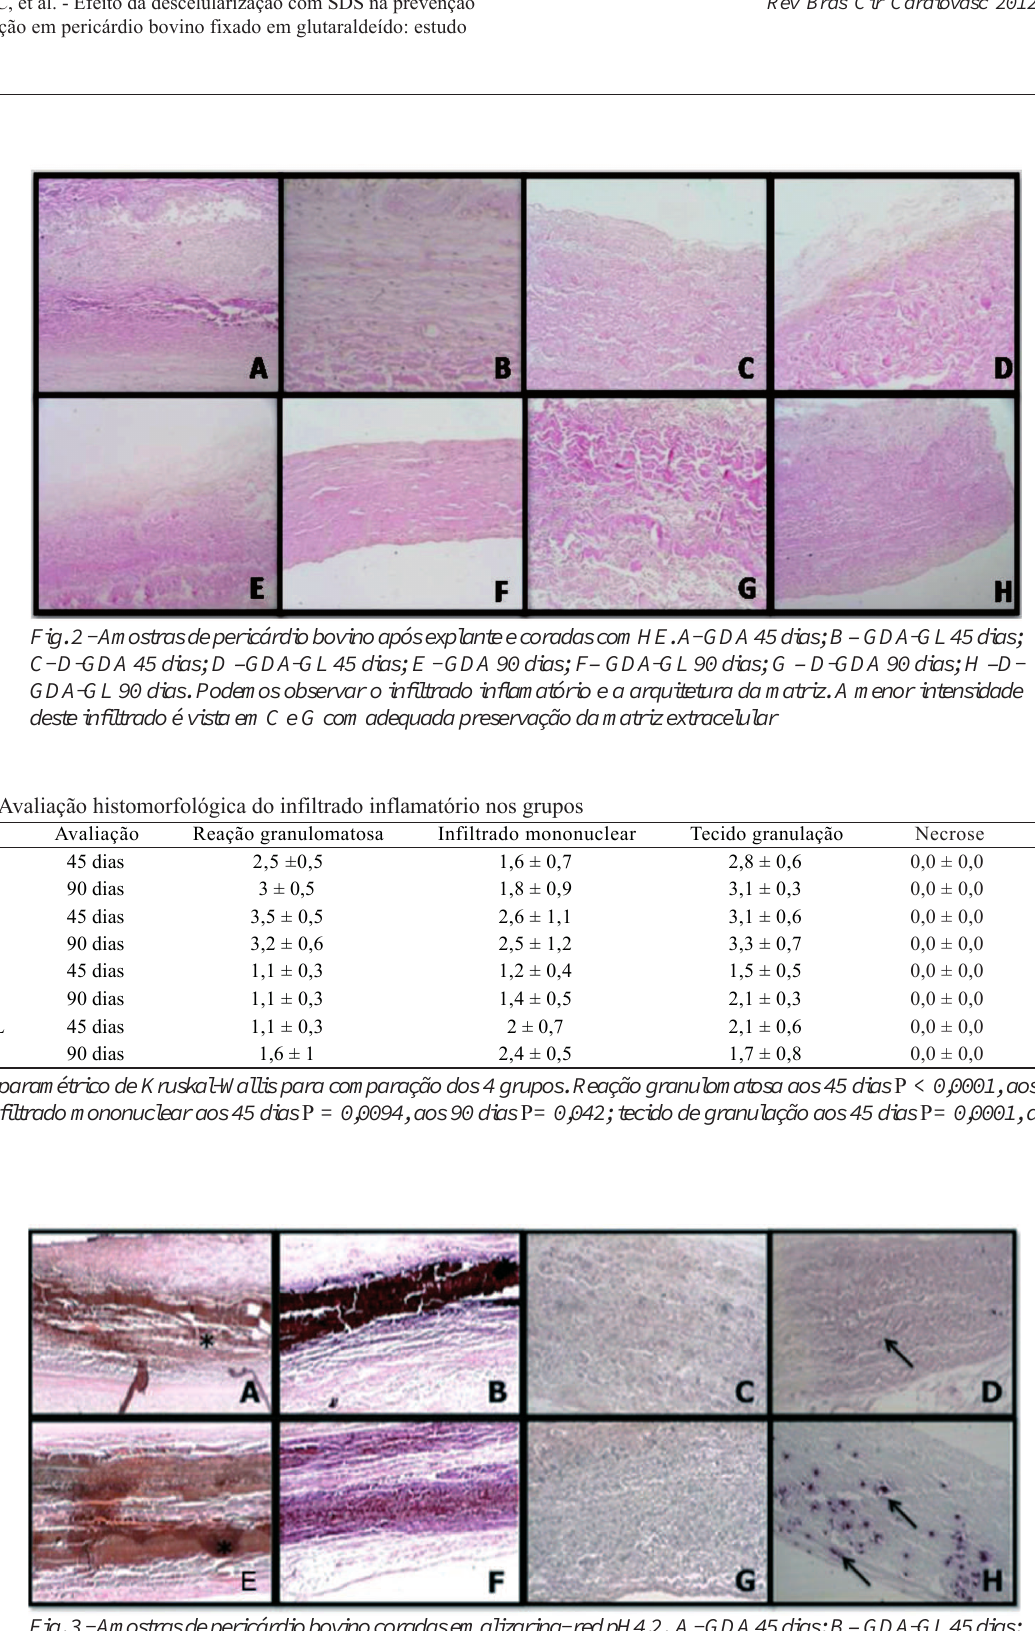
observamos calcificações focais (setas)